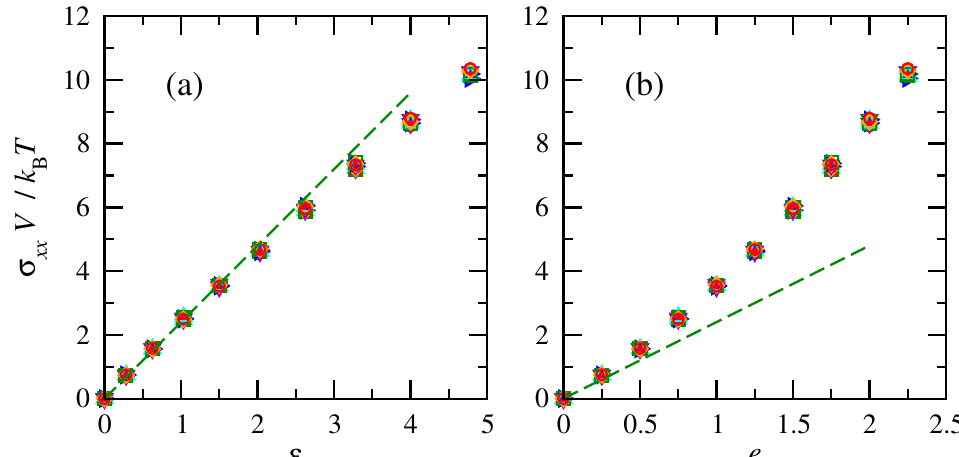
Figure 7. Normalized tensile stresses vs. ( a ) finite and ( b ) engineering strain for cis- and trans-1,4- polybutadiene RIS chains of 50 repeat units. Symbols and colors follow convention of Figure 6. Dashed lines indicate an initial linear fit with E = 2.4 k B T / V .